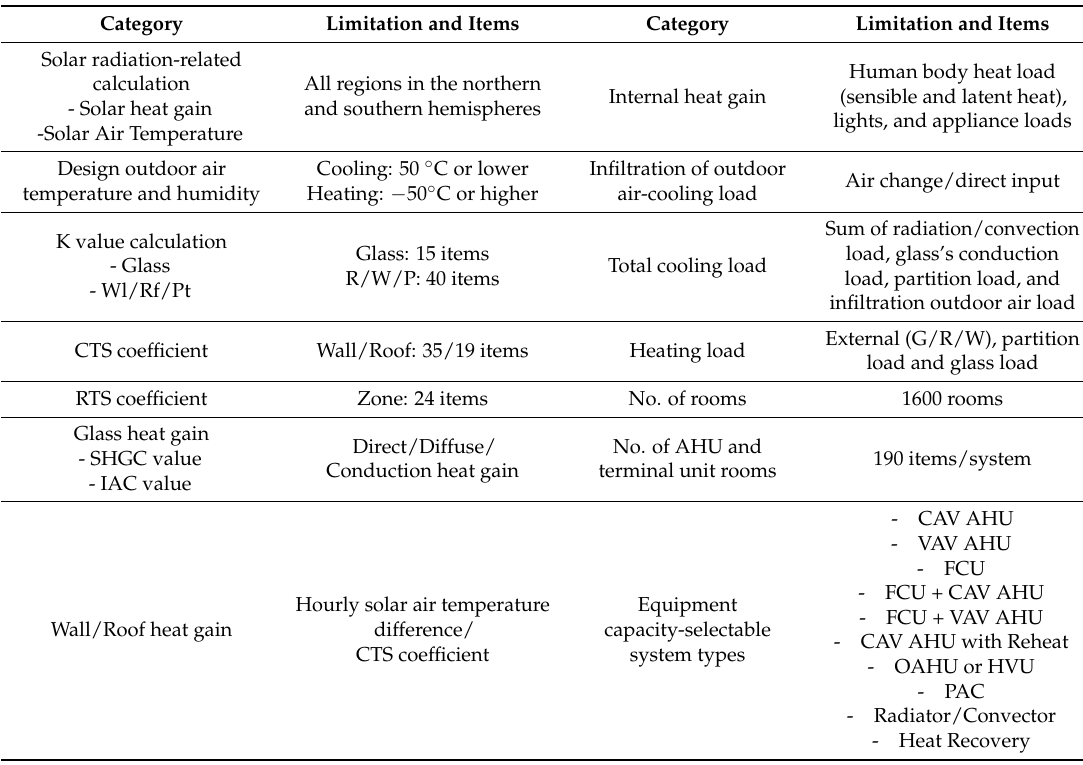
Table 3. Application scope and calculation range of RTS-SAREK